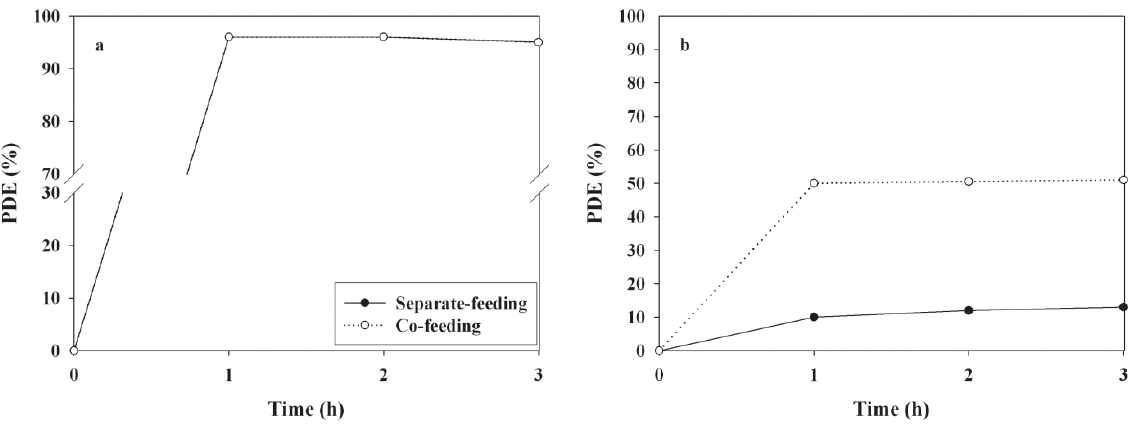
Figure 7. Time-series photocatalytic efficiencies (PDEs, %) of ( a ) 2-propanol; and ( b ) TCE as determined using TiO calcined at 450 °C according to feeding type 2 (separate- and